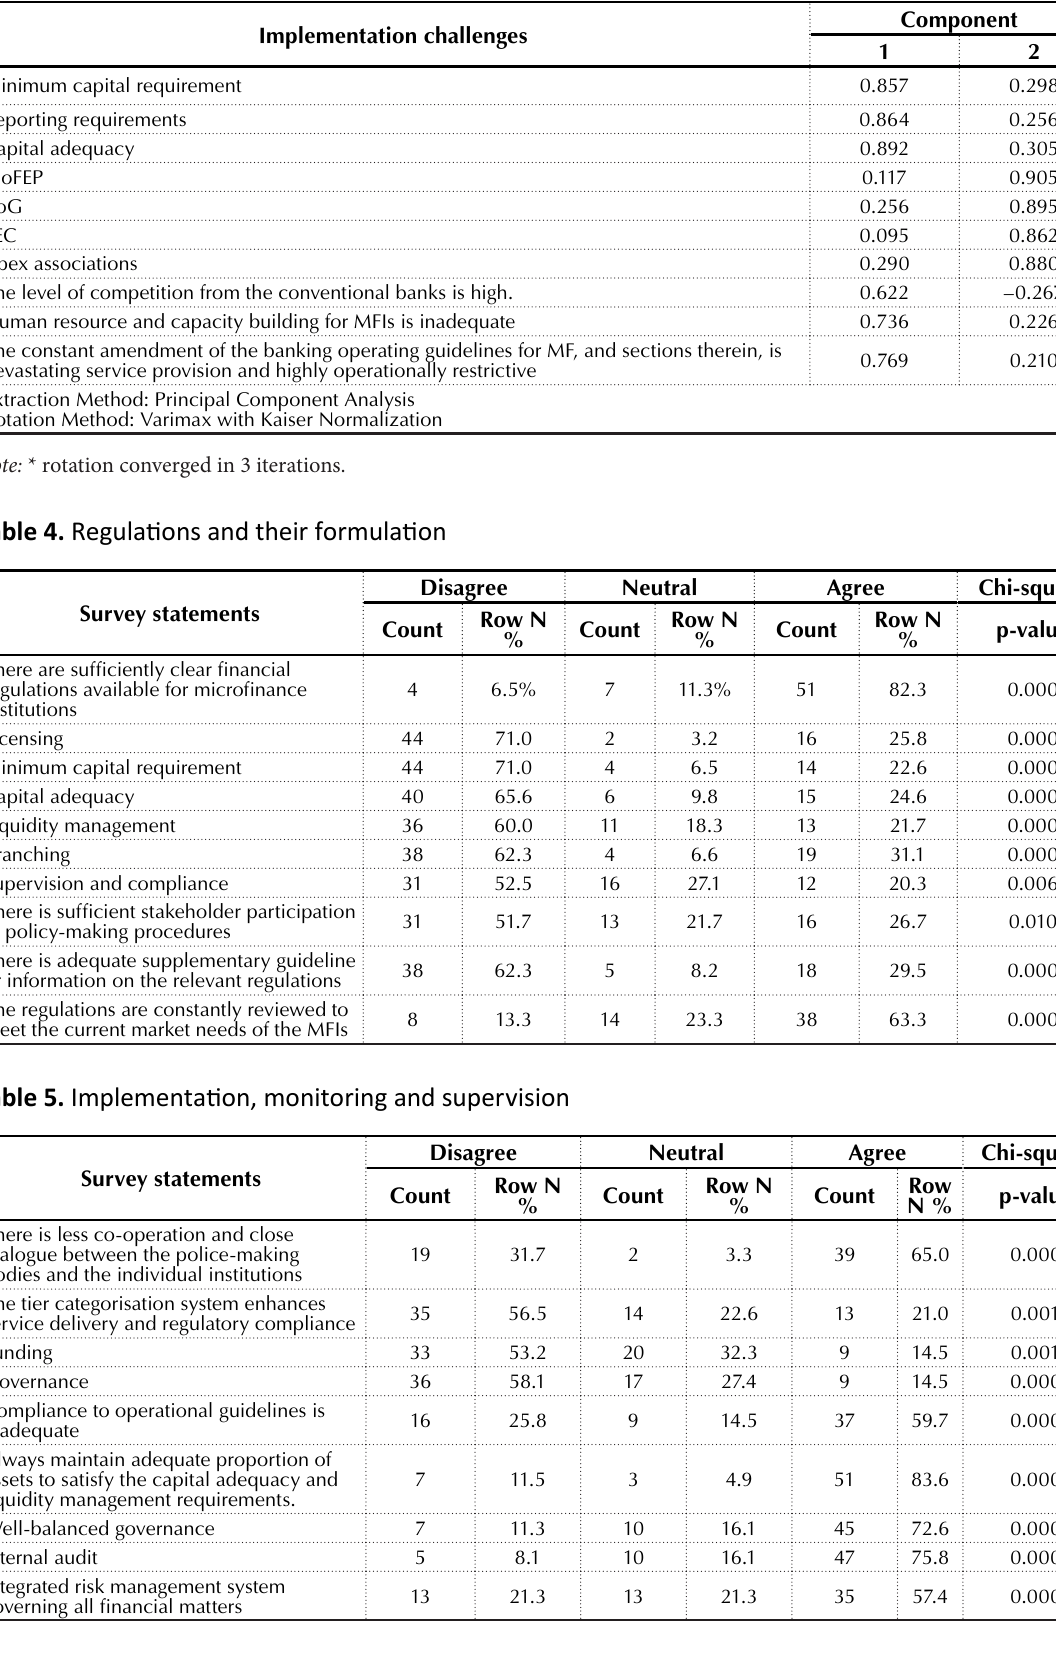
Table 3. Rotated Component Matrix*